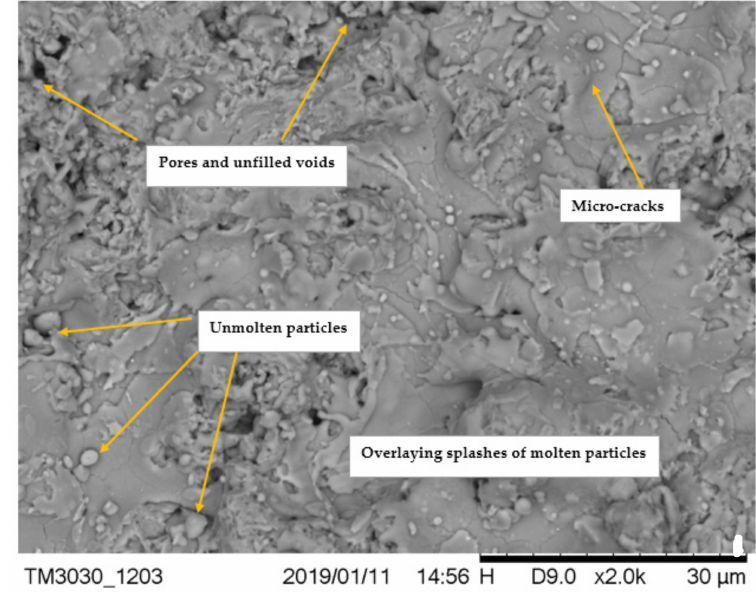
Figure 2. Scanning electron microscopy (SEM) images showing typical atmospheric plasma-sprayed coating morphology for chromium oxide coating on Q235